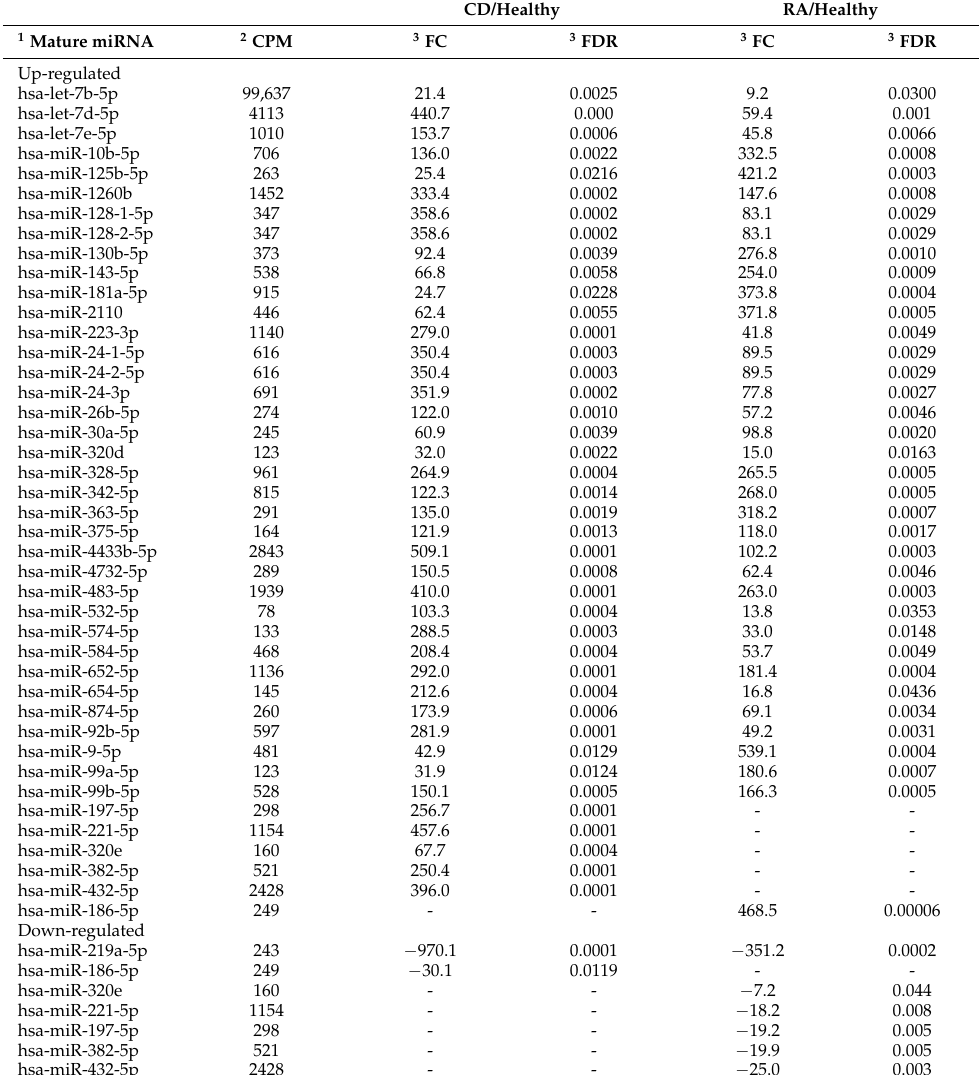
Table 1. Known miRNAs commonly regulated in plasma of Crohn’s disease (CD) and rheumatoid arthritis (RA) patients compared to healthy